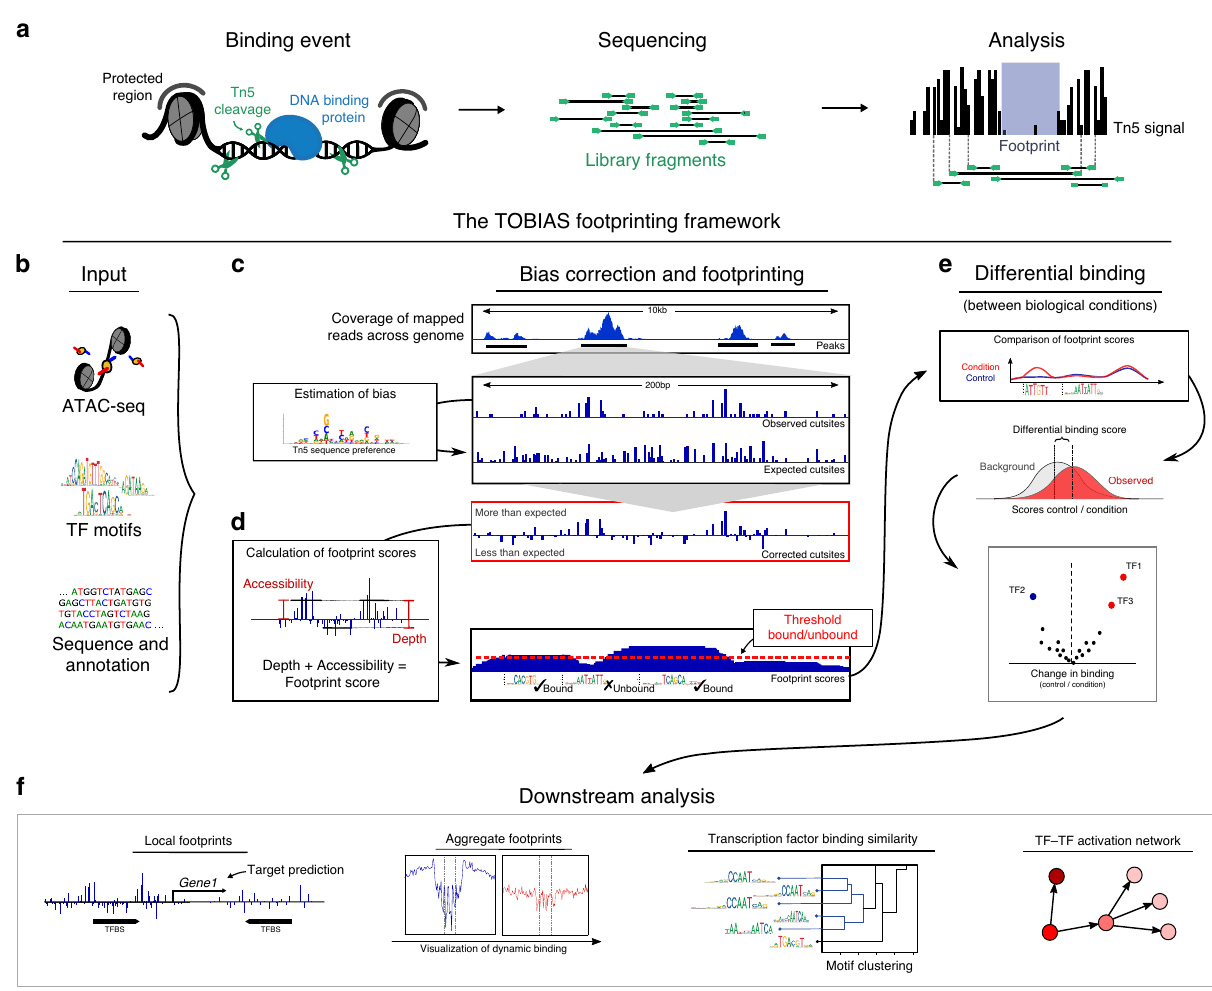
Fig. 1 The TOBIAS digital genomic footprinting framework. a The concept of footprinting using ATAC-seq. Tn5 transposase cleaves DNA and inserts sequencing adapters, but is unable to cut chromatin occupied by proteins such as nucleosomes (gray) and other DNA binding proteins e.g., transcription factors (blue). Sequencing libraries of DNA fragments are sequenced to yield reads (green). During analysis, each read is mapped to the genome and used to create a signal of single Tn5 insertion events (black bars), in which binding of protein is visible as depletion of the signal (de fi ned as the footprint). b TOBIAS uses reads from ATAC-seq, transcription factor motifs and sequence annotation in standard formats as input. c Bias correction of Tn5 signal. In the fi rst step, TOBIAS reads the observed Tn5 cutsites and estimates the underlying Tn5 sequence preference. TOBIAS then calculates the expected Tn5 cutsites per region, which represent the background probability of Tn5 insertion. Using the expected signal track, the Tn5 bias corrected cutsites are obtained (red box). d Footprinting to estimate transcription factor binding. The corrected cutsites enable calculation of footprint scores with a scoring function taking into account both the accessibility and depth of the local footprint (as depicted in the box labeled “ Calculation of footprint scores ” ). This continuous footprint score is correlated with the presence of transcription factor binding sites in the genome, and a threshold is set to distinguish between bound and unbound sites. e Differential footprinting. If multiple conditions are investigated, the differential binding module summarizes individual site scores (upper black box) for each TF, and compares them between conditions (gray/red curve center) in order to de fi ne differentially bound TFs. Performed on all TFs under investigation, a volcano plot illustrates the global changes in transcription factor binding. f Additional analysis modules. After the main TOBIAS analysis, a variety of downstream analysis can be applied including visualization of local and aggregated footprints across conditions, comparison of binding speci fi city between individual transcription factors and TF network